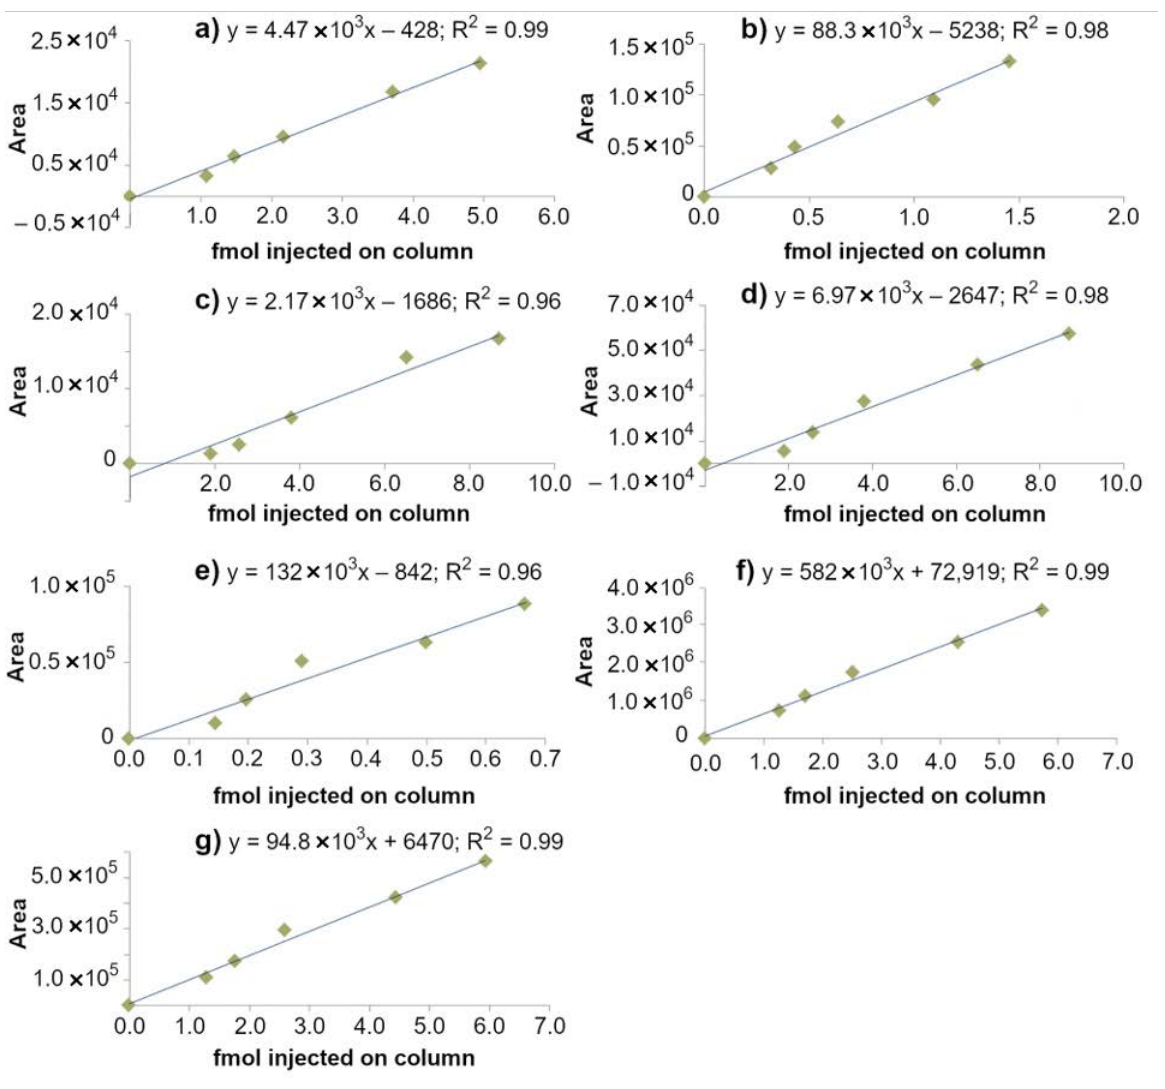
Figure 4. Linear regression curves of ( a ) (+)-anti-BPDE-Lys; ( b ) ( − )-anti-BPDE-Lys; ( c ) (+/ − )-syn BPDE-Lys (peak 1, retention time 9.0 min); ( d ) (+/ − )-syn BPDE-Lys (peak 2, retention time 9, 9 min); ( e ) (+)-anti BPDE-His-Pro; ( f ) ( − )-anti BPDE-His-Pro; and ( g ) (+/ − )-syn BPDE-His-Pro. Different con- centration levels were achieved by dilutions of in vitro alkylated human SA (see Sections 2.3 and